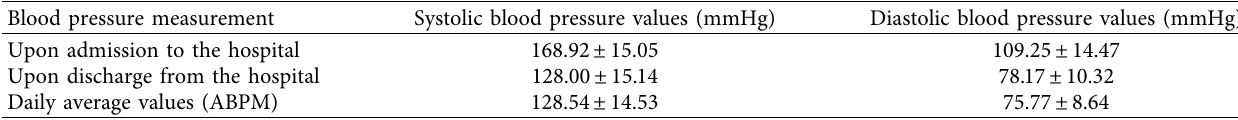
Table 3: Blood pressure values of the patients admitted to the hospital due to hypertension ( n � 204).